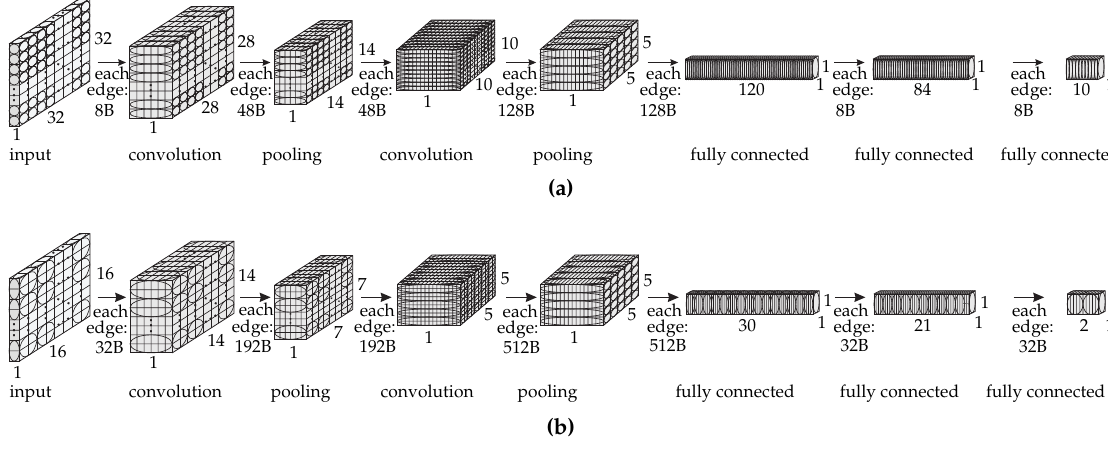
Figure 3. LeNet architecture and vertex granularity used in our experiments. Each cube stands for a CNN neuron while each circle is a vertex in the source dataflow graph. Edges represent data transfers and are labeled with the number of bytes per inference that each edge must transfer. ( a ) LeNet 1:1 : the original LeNet with 2343 vertices. ( b ) LeNet 2:1 : LeNet with 604 vertices, in which the width and height of each convolution and pooling layer were divided by two, except for the last pooling layer, and the depth of the fully connected layers was divided by